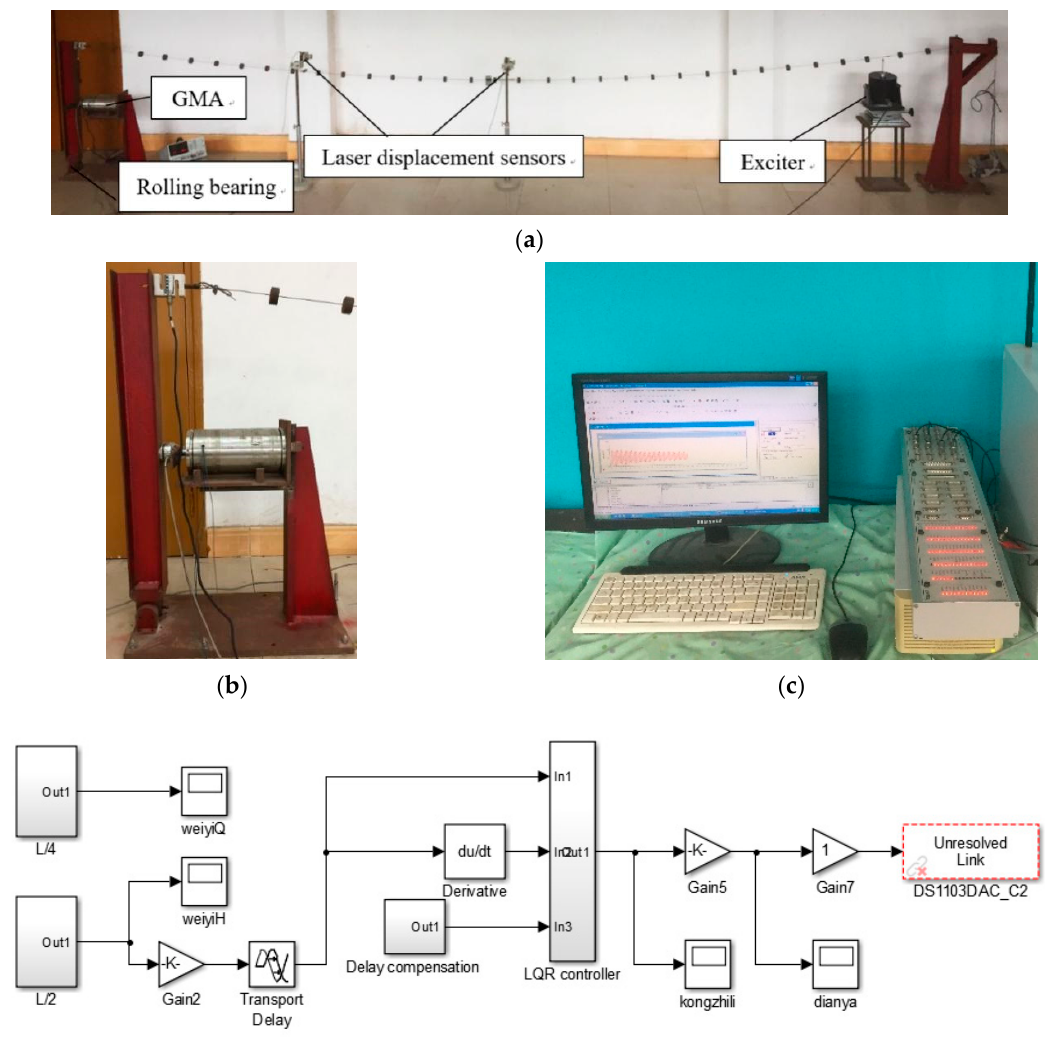
Figure 9. The layout of the cable vibration control experiment. ( a ) Cable model of experiment. ( b ) GMA. ( c ) dSPACE. ( d ) The time delay compensation module in Simulink. ( b ) GMA. ( c ) dSPACE. ( d ) The time delay compensation module in